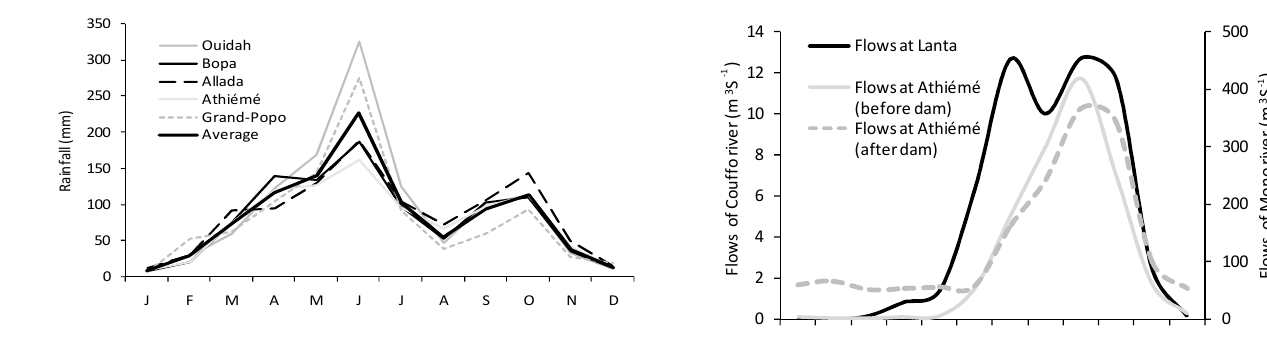
Figure 2. Mean monthly rainfall at the stations around Ahémé lake over the period 1961–2010.